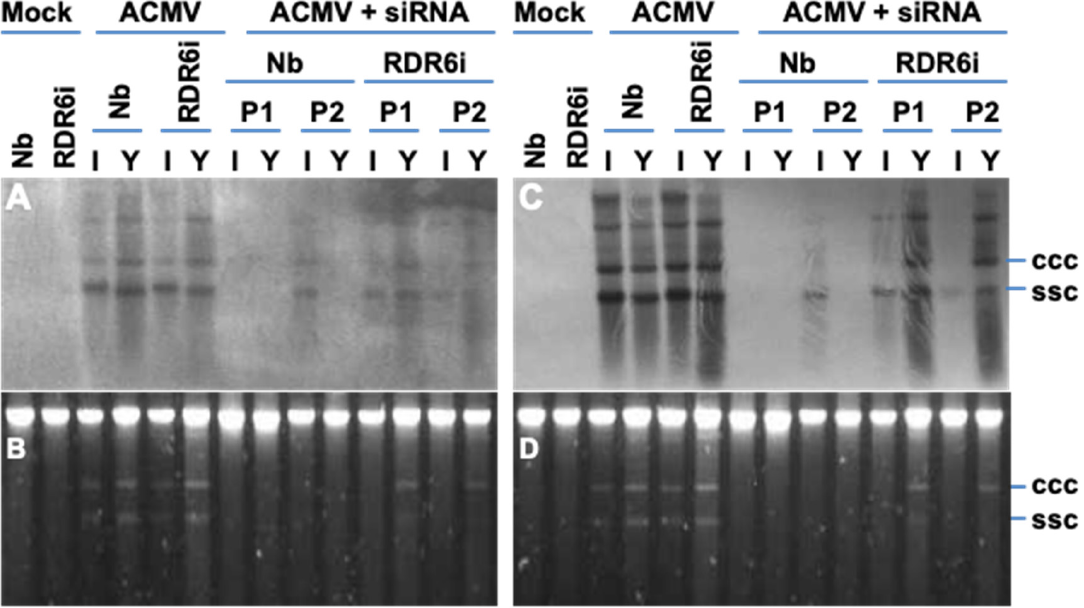
Figure 5. Involvement of RDR6 in hotspot ds-siRNA-mediated suppression on ACMV DNA replication. ( A – D ) Southern blot detection and ACMV DNA accumulation. Total DNAs were extracted from systemic young (Y) and inoculated (I) leaf tissues of wild type N. benthaniana (Nb) and transgenic NbRDR6i (RDR6i) line plants with mock inoculation and of plants inoculated with ACMV alone (ACMV), or together hotspot ds-siRNA (ACMV + siRNA) at 14 days post-inoculation. Duplicate plants (P1 and P2) were sampled for detection. Viral DNA was detected by probes specific to DNA-A ( A ) or DNA-B ( C ). GelRed staining shows equal loading of total DNA ( B , D ). The positions of single-stranded circular (ssc) and covalently closed circular (ccc) DNA are indicated. It should be noted that the profiles of both DNA A and DNA B are almost identical. The different intensities between panel A (DNA-A) and panel C (DNA-B) should not be compared directly because the two blots were probed with different probes. It is possible that the different signal intensities may be due to various strength of the DIG-labelled probes. On the other hand, it is also worthwhile mentioning that ACMV DNA-A encodes essential function for viral DNA replication, and replication of DNA-B is completely dependent on DNA-A, although DNA-B is required for systemic spread of ACMV in plants. Therefore, the differential blot signals do not imply that ACMV lacking DNA-A can frequently be involved in systemic infection to young leaves since ACMV lacking DNA-A will not be able to establish any local or systemic infection.